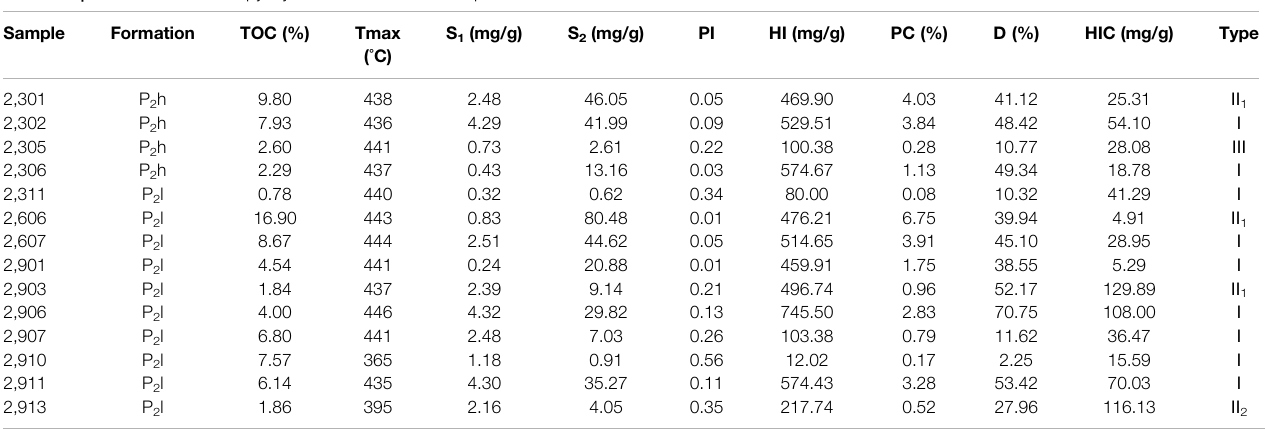
TABLE 1 | TOC and Rock-Eval pyrolysis data of selected